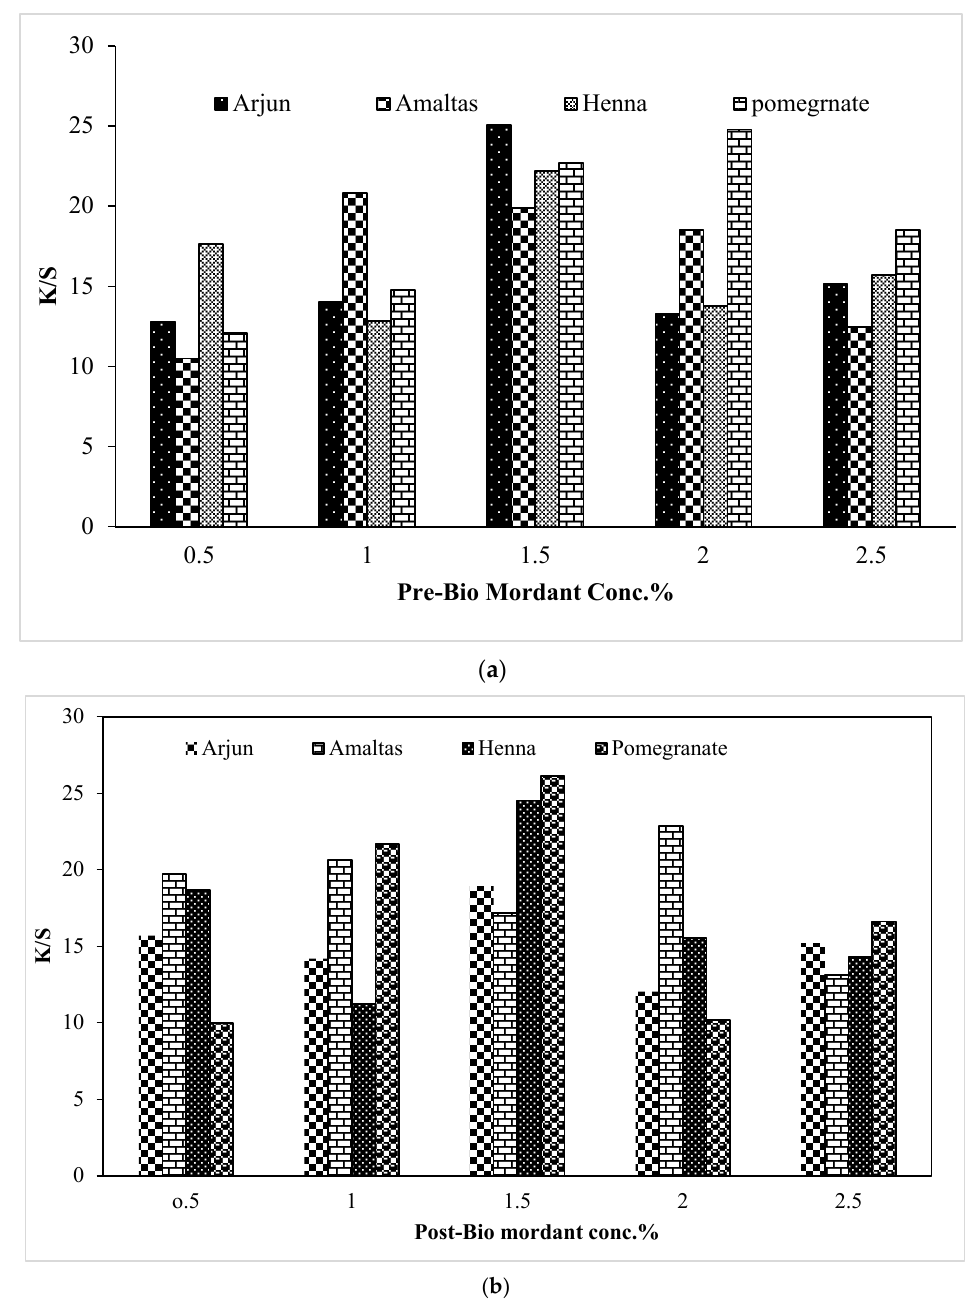
Figure 6. ( a ) Pre-bio mordant of silk fabric with red sandalwood (RSW) powder at optimized conditions. ( b ) Post-bio mordant of silk fabric with red sandalwood (RSW) powder at optimized conditions.